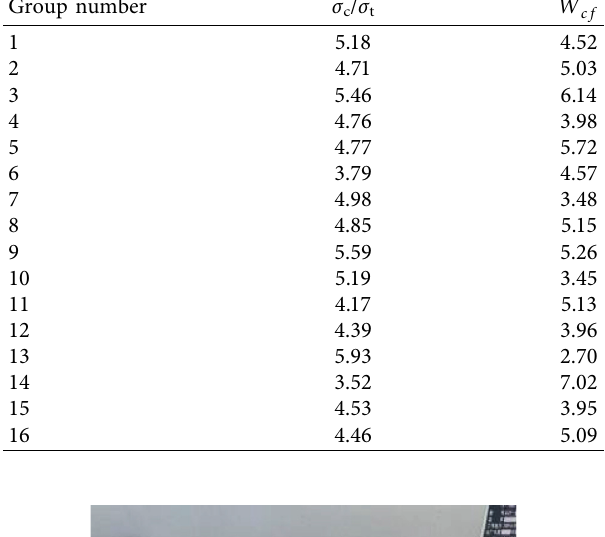
Table 12: Judgement of rockburst tendency of similar materials covered by the study.